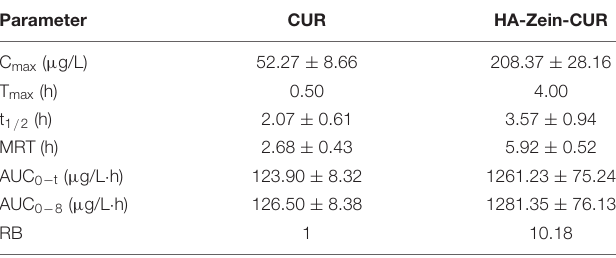
TABLE 3 | Pharmacokinetic parameters of free CUR and HA-Zein-CUR after intragastric administration in mice. Parameter CUR